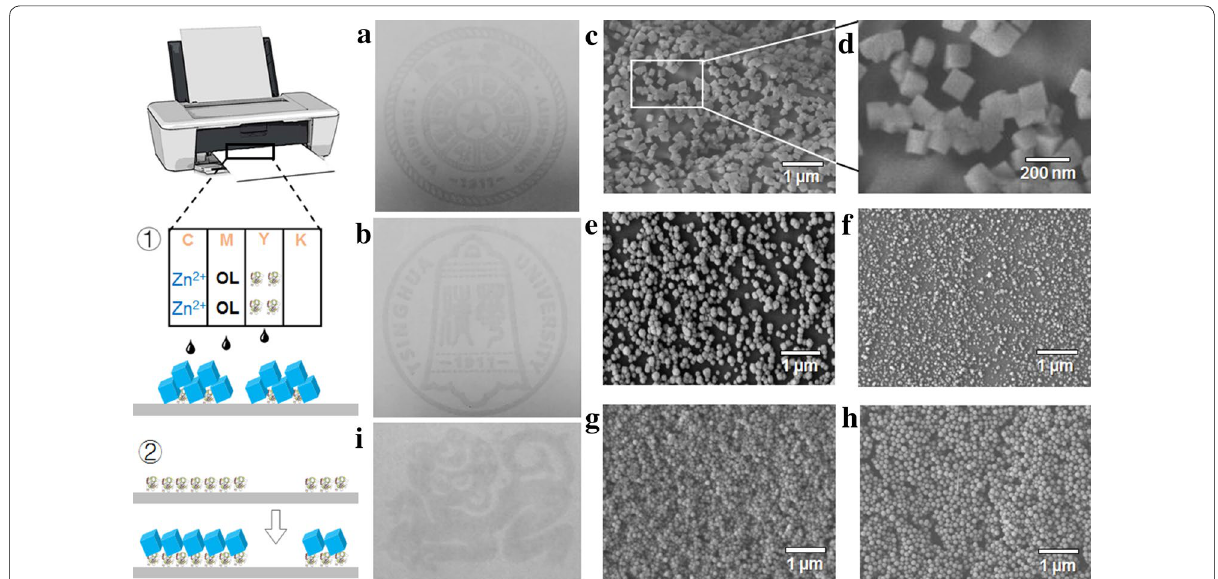
Fig. 1 a , b Printed patterns formed by ZIF-8 crystals on filter paper, and patterns (approximately 5 cm SEM images of pure ZIF-8 particles printed on ( c , d ) filter paper (8 times printing), e PVC film (8 times printing), f PET film (8 times printing), g hydrophilic printing film (1 time printing). h SEM image of ZIF-8 particles grown on PET film printed with protein and a pattern ( i ) (approximately 5 cm 3 cm) of a monkey representing lunar year of 2016 formed by ZIF-8 particles grown on PET film printed with protein. Organic ligand 2-MeIM × is abbreviated as OL in the